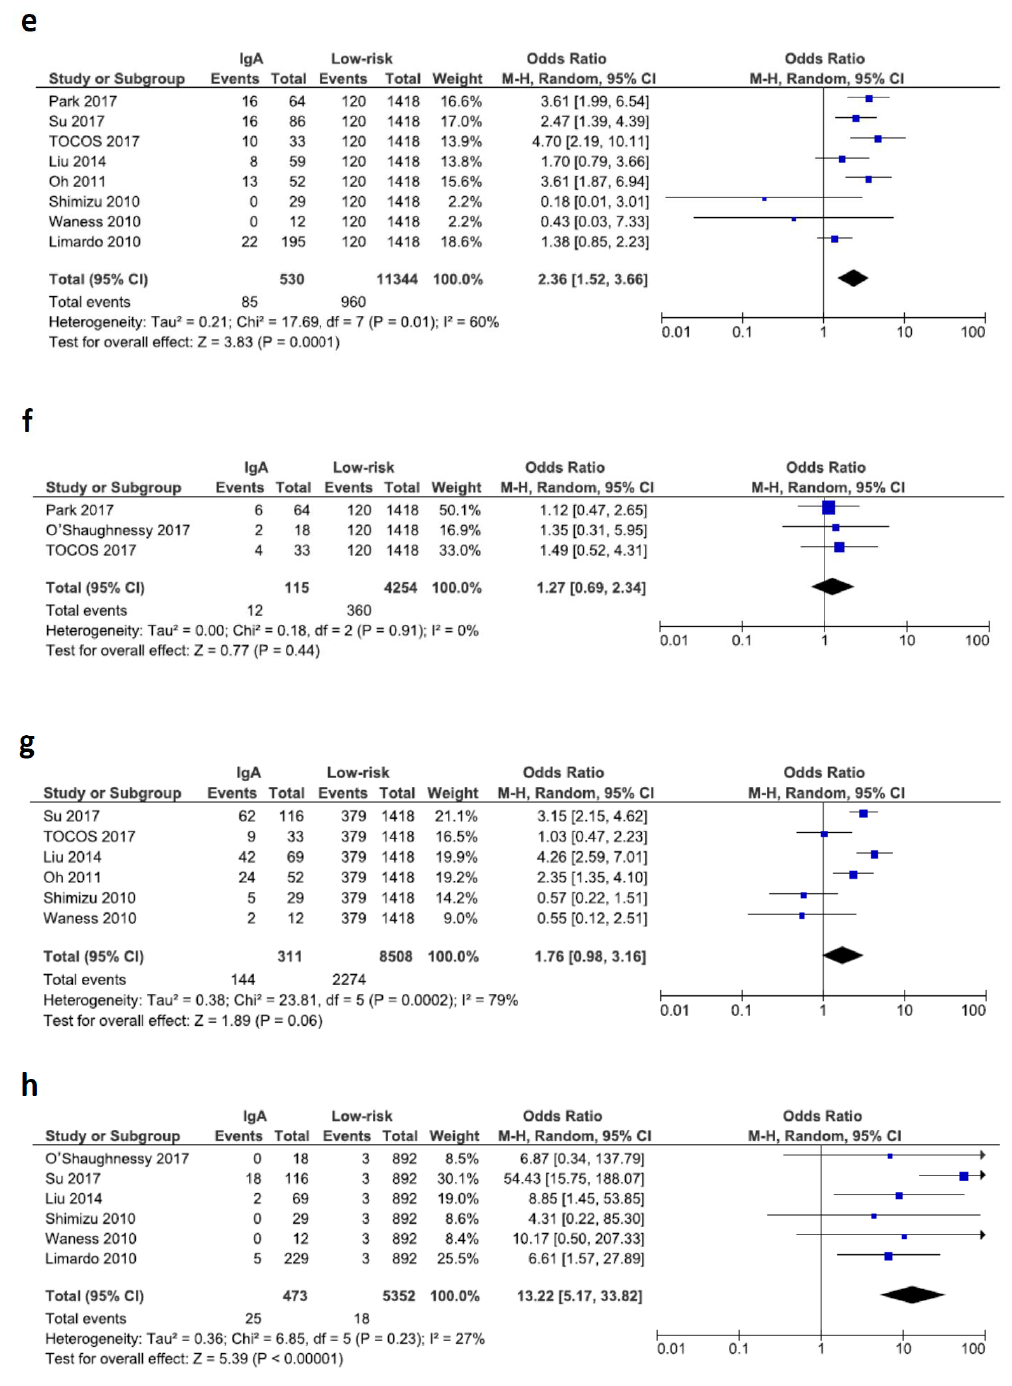
Figure 3. Odds ratio for different pregnancy related outcomes. SGA: small for gestational age. IUGR: intrauterine growth restriction. PE: preeclampsia. CI: confidence intervals.